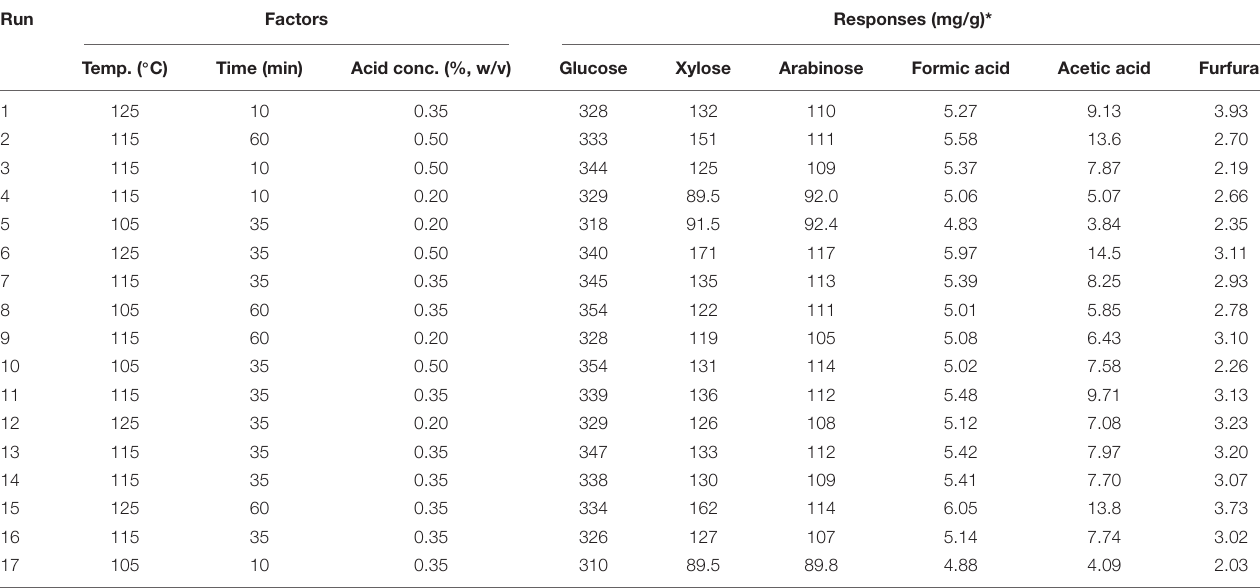
TABLE 2 | Pretreatment factors and experiment results in the experiments designed by the central composite design from response surface